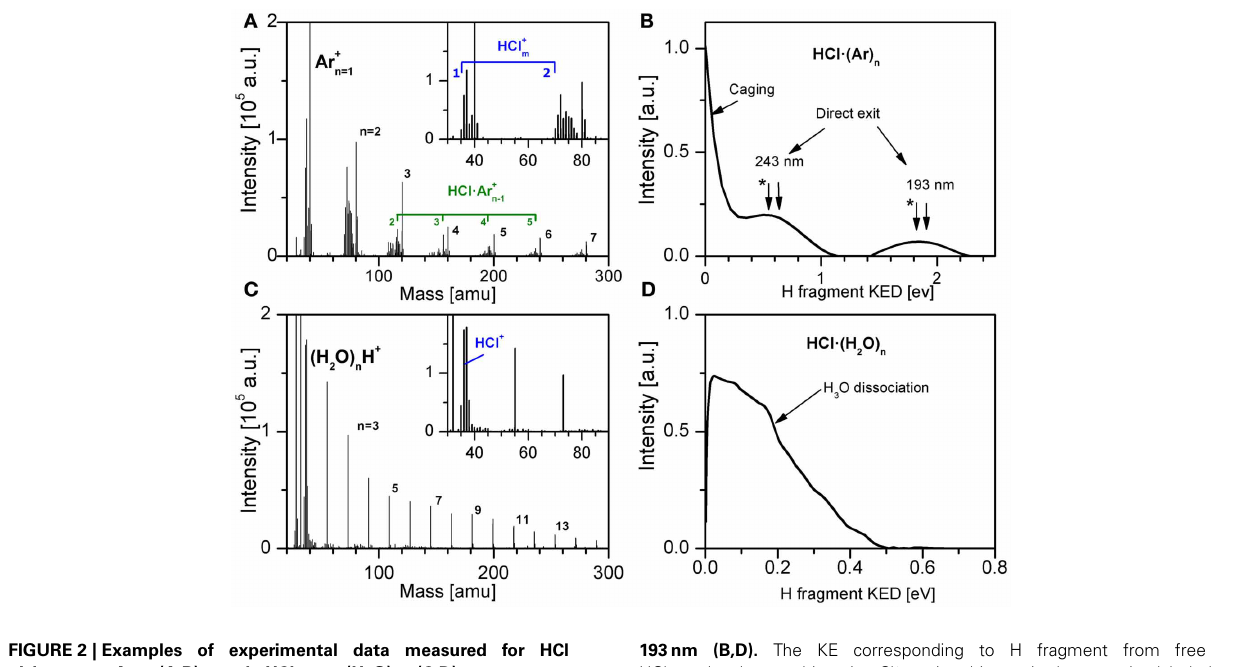
193nm (B,D). The KE corresponding to H fragment from free HCl molecule resulting in Cl ∗ spin-orbit excited state is labeled by ∗ in (B) .